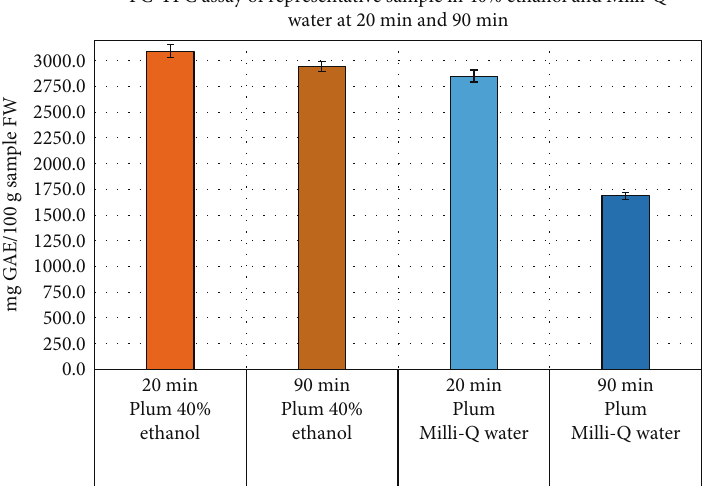
Figure 5: FC-TPC assay of a representative sample in 40% ethanol and Milli-Q water at 20 and 90min.